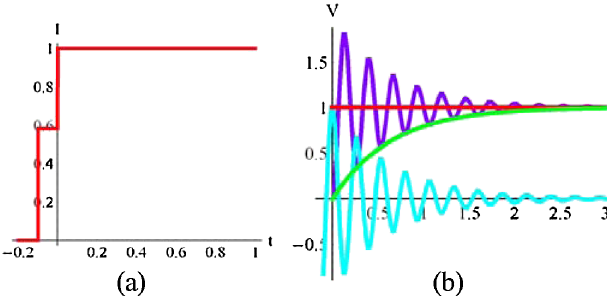
FIG. 13. (Color) Two-step functions. (a) Current profile. (b) The reduced filling time by cancellation of the two beating transients. The cyan curve is the voltage induced by the first step-pulse, the purple curve is induced by the second one, the red curve is the final voltage by summing two beating transients, and the green curve is the standard filling time curve for a single step